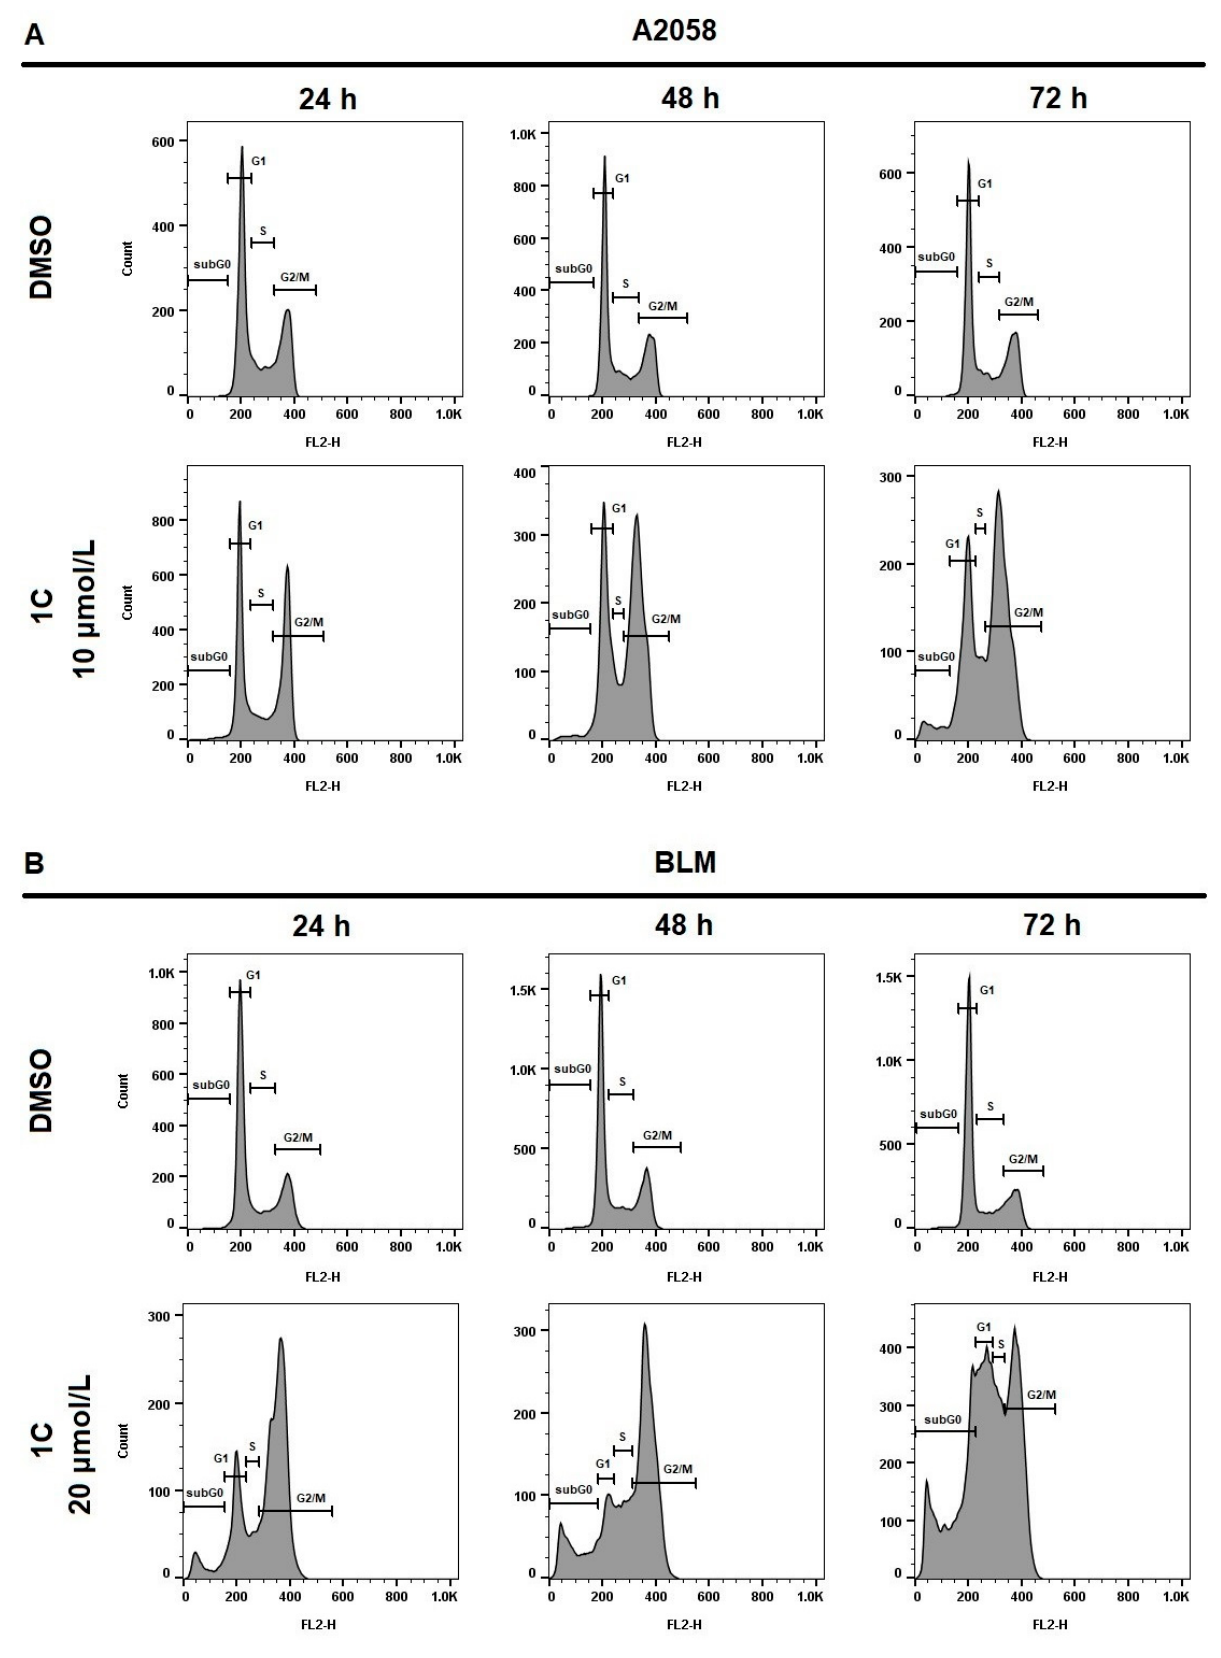
Figure 3. Cell cycle analysis of A2058 ( A ) and BLM ( B ) melanoma cells after treatment with chalcone 1C for 24, 48 and 72 h at a concentration of 10 µ mol/L (A2058) and 20 µ mol/L (BLM). Representative histograms from three independent experiments.